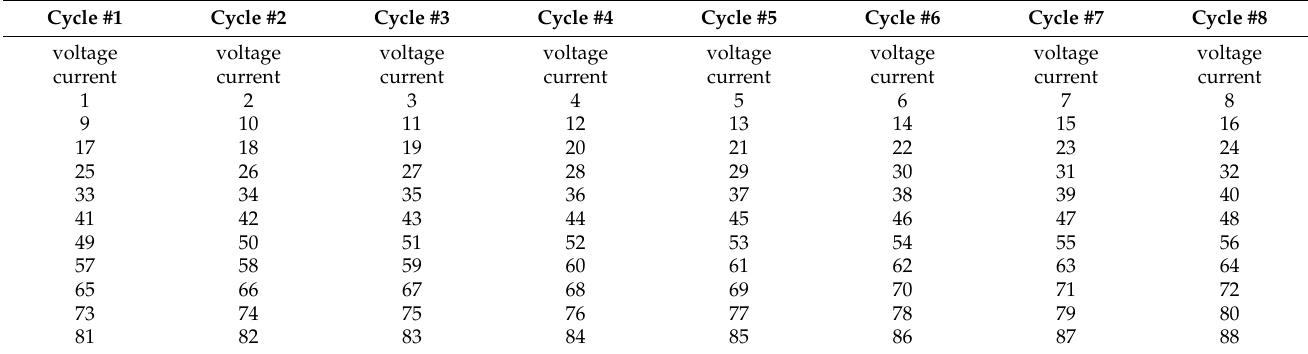
Table 1. Query order divided into cycles (the values mean the IDs of the battery packs).